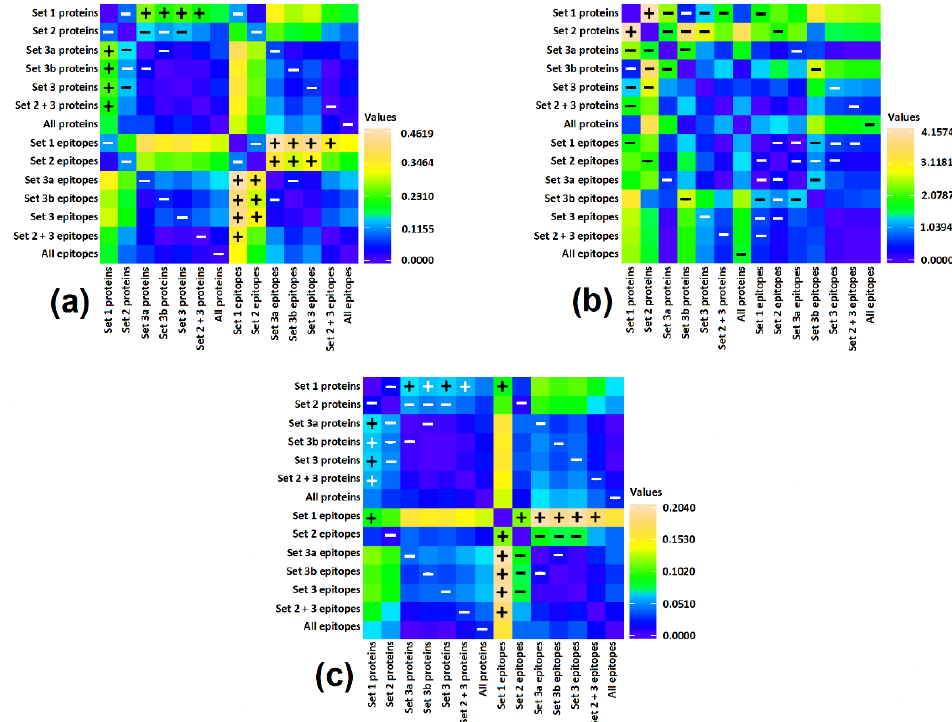
Figure 8. Differences in scores between groups of proteins containing particular sets of domains, expressed as matrices of Euclidean distances: ( a ) ∑ A; ( b ) DH t [%]; ( c ) ∑ A E Differences subjected to t -test are labeled. Symbol “+” indicates differences that are statistically significant at p < 0.05. Symbol “ − “ indicates a lack of statistically significant difference.